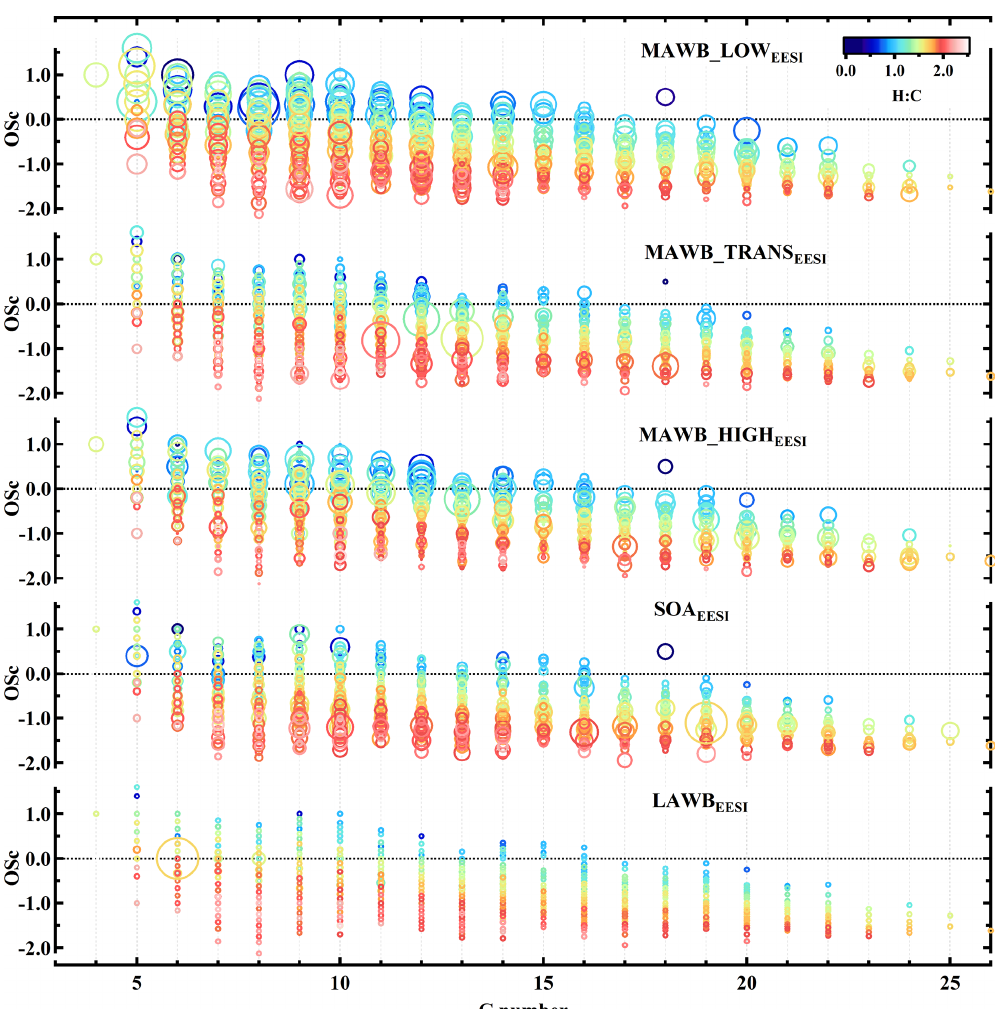
Figure 8. Carbon oxidation state (OS c ) as a function of number of carbon atoms for the factors, more aged biomass burning_low temperature, more aged biomass burning_transition, more aged biomass burning_high temperature, secondary organic aerosol, and less aged biomass burning. Points are colored by atomic H : C ratio and sized by the fraction of each ion apportioned to the designated factor.